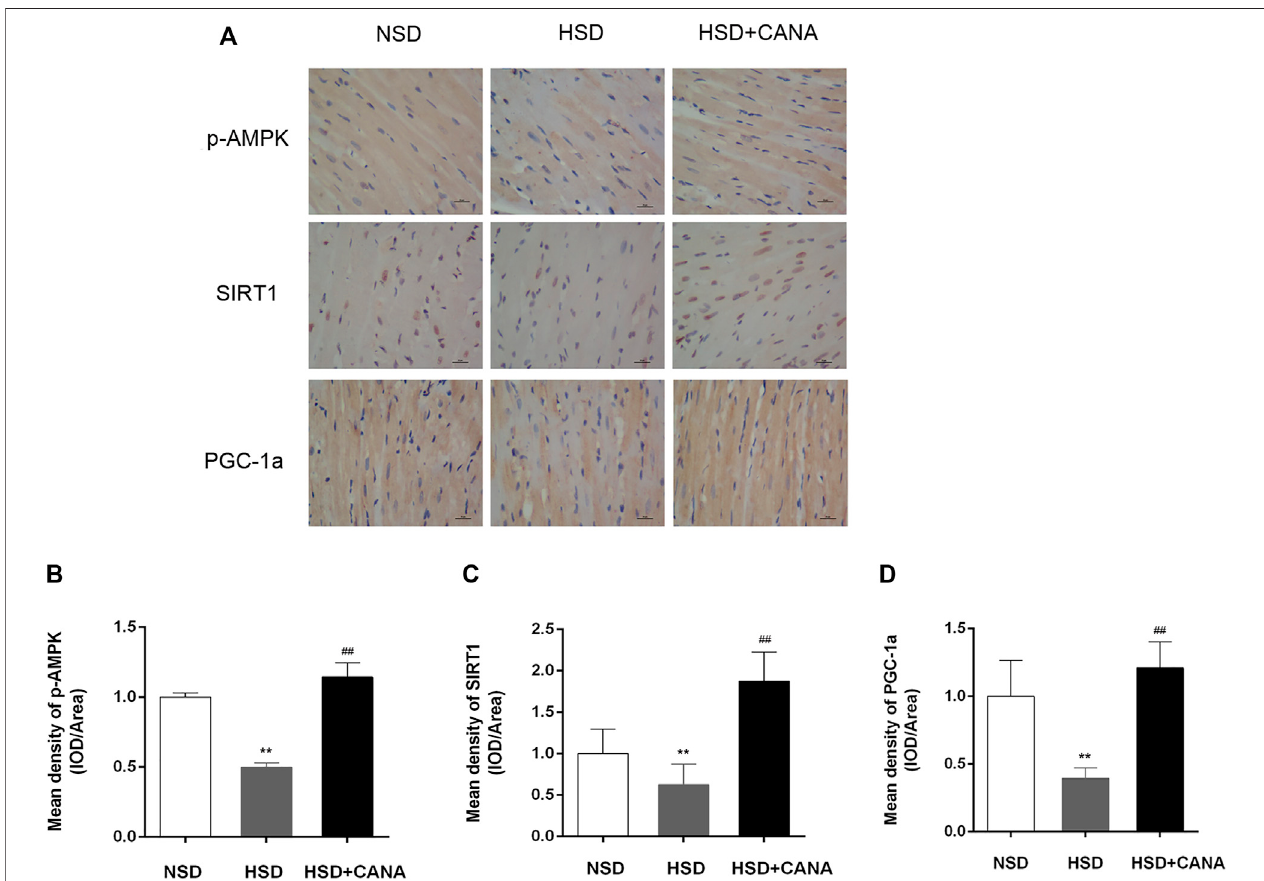
FIGURE8| CANAimprovedcardiacfunctionbyactivationoffattyacidoxidationandketogenesisandreducingoxidativestressthroughtheAMPK/SIRT1/PGC-1a pathway. (A) The protein expression ofAMPK, p-AMPK, SIRT1,and PGC-1a wasdetected via immunohistochemical staining; (B) Mean density ofp-AMPK (IOD/Area); (C) Mean density of SIRT1 (IOD/Area); (D) Mean density of PGC-1a (IOD/Area); IOD, integrated optical density. ** p < 0.01 vs. NSD. ## p < 0.01 vs.